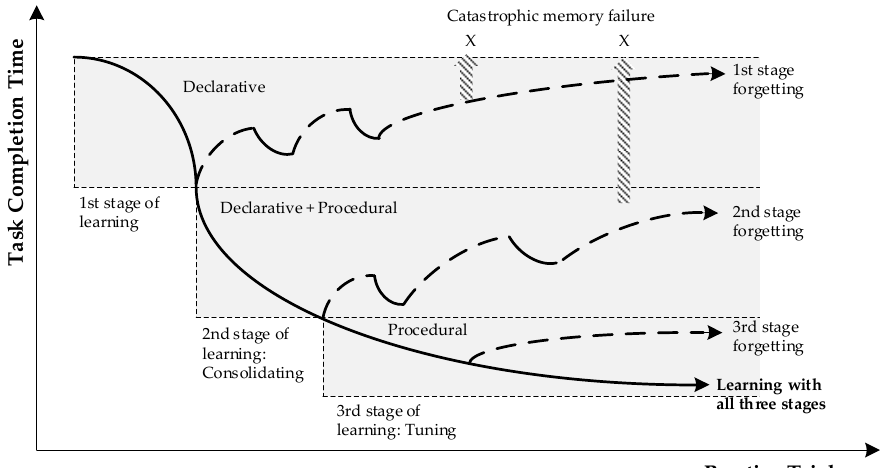
Figure 2. Loss of skills according to three stages of learning and lack of practice. Adapted from